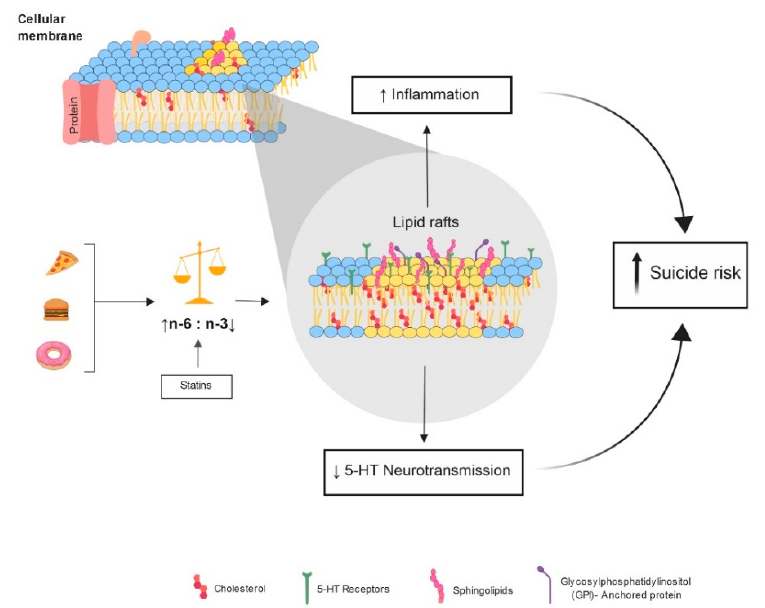
Figure 1. Theories of two biologic mechanisms that associate cholesterol and suicidal behavior. Abbreviations: 5-HT: 5-hydroxytryptamine receptors; GPI: glycosylphosphatidylinositol—anchored protein; n-3: omega 3; n-6: omega 6; PUFA: polyunsaturated fatty acids; ↑ , increased; ↓ , decreased.